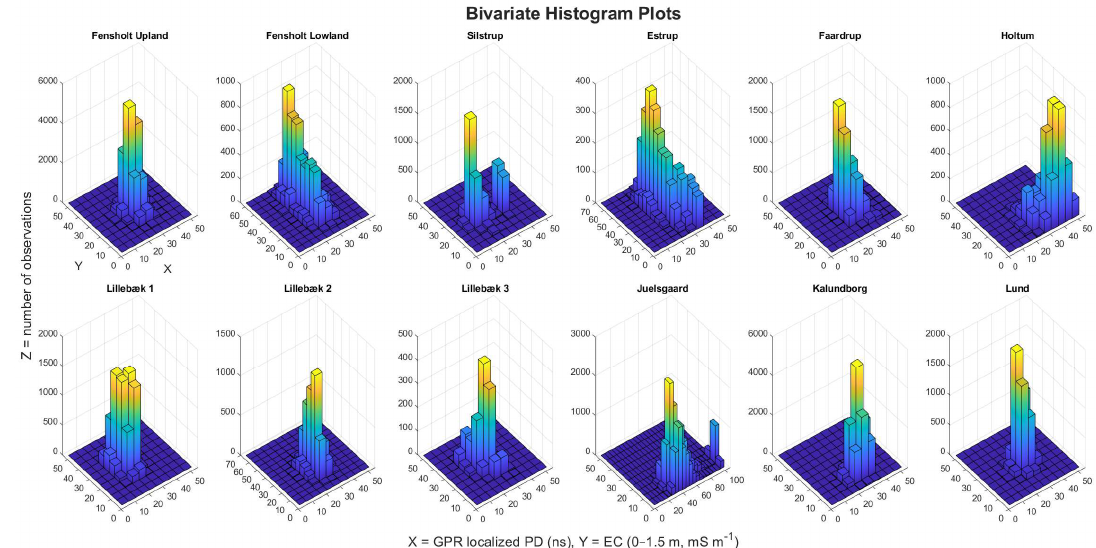
Figure 11. Bivariate histogram plots showing the comparison between the 3D-GPR localized penetration depth (ns) and EC (0–1.5 m, mS m − 1